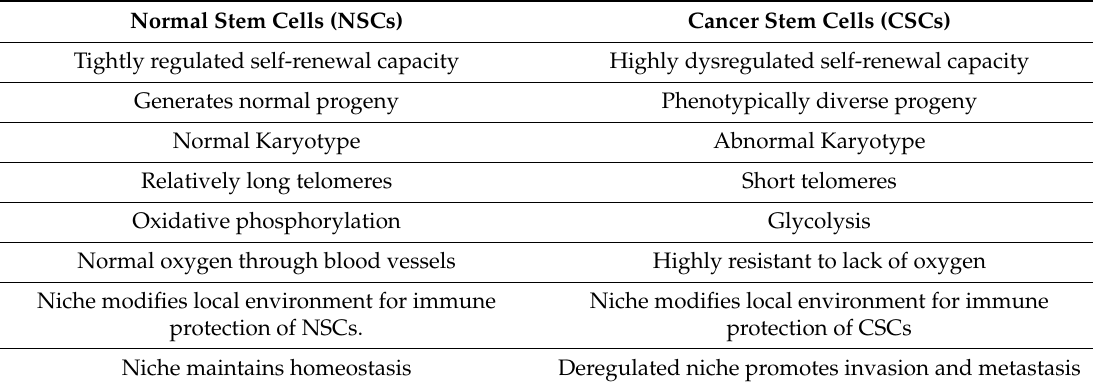
Table 1. Distinguishing Characteristics of Normal and Cancer stem